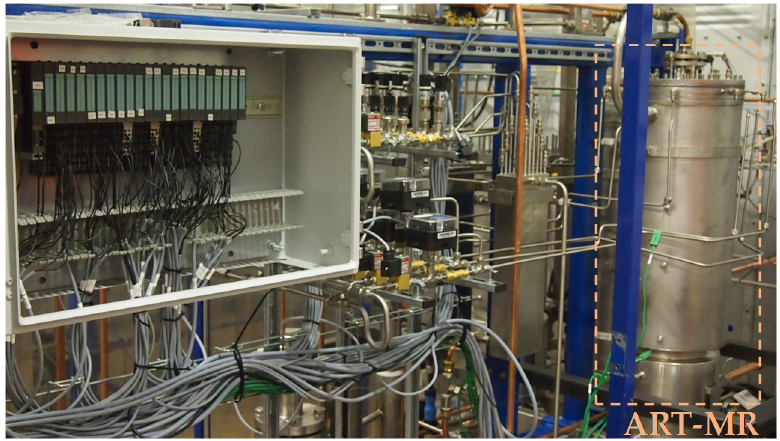
Figure 12. Picture of the prototype reactor for the ATR process where the placement of the Autothermal Reforming ‐ Membrane reactor (ATR ‐ MR) is highlighted.